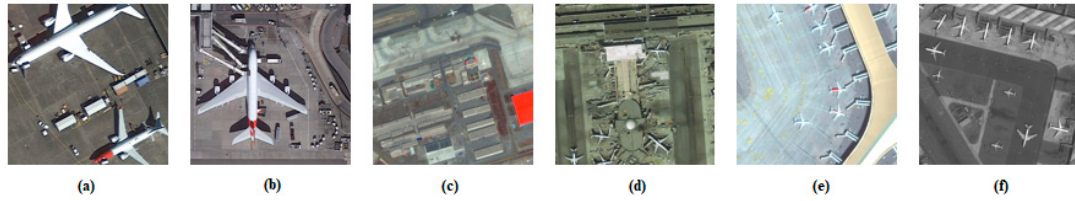
Figure 1. Patches from the DOTA test set; ( a ) cropped, ( b ) very big, ( c ) very small, ( d ) complex background, ( e ) illuminance effect, and ( f ) panchromatic samples.